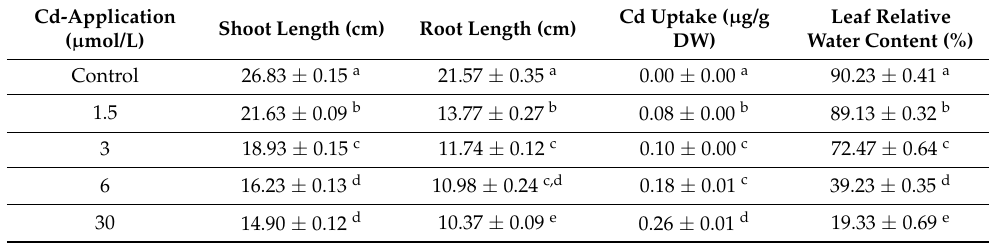
Table 1. Changes in root and shoot lengths of E. sativa with respect to Cd applications.